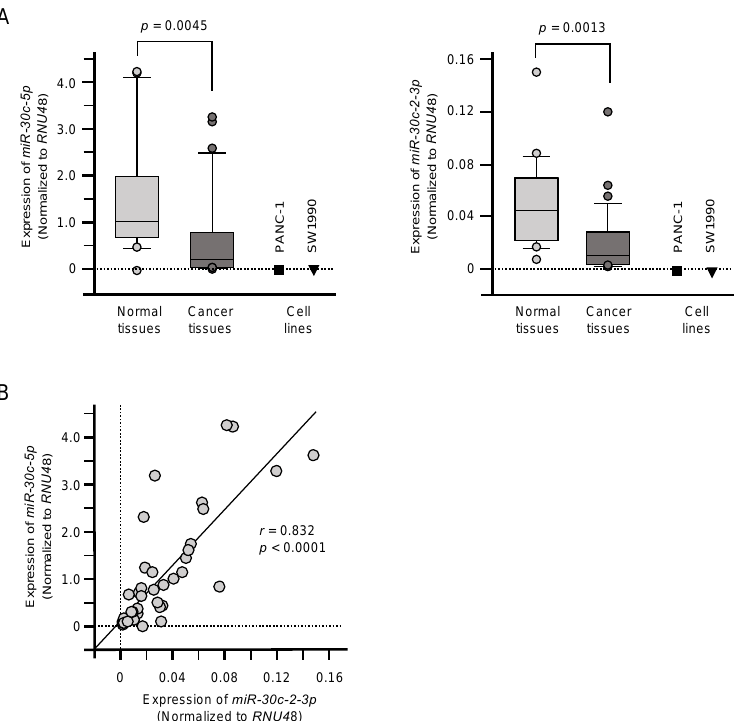
Figure 1. Downregulation of miR-30c-5p and miR-30c-2-3p in pancreatic ductal adenocarcinoma (PDAC). ( A ) Expression levels of miR-30c-5p and miR-30c-2-3p in PDAC clinical specimens and cell lines (PANC-1 and SW1990). Data were normalized to the expression of RNU48. ( B ) Spearman’s rank tests showed positive correlations between the expression levels of miR-30c-5p and miR-30c-2-3p in clinical specimens.